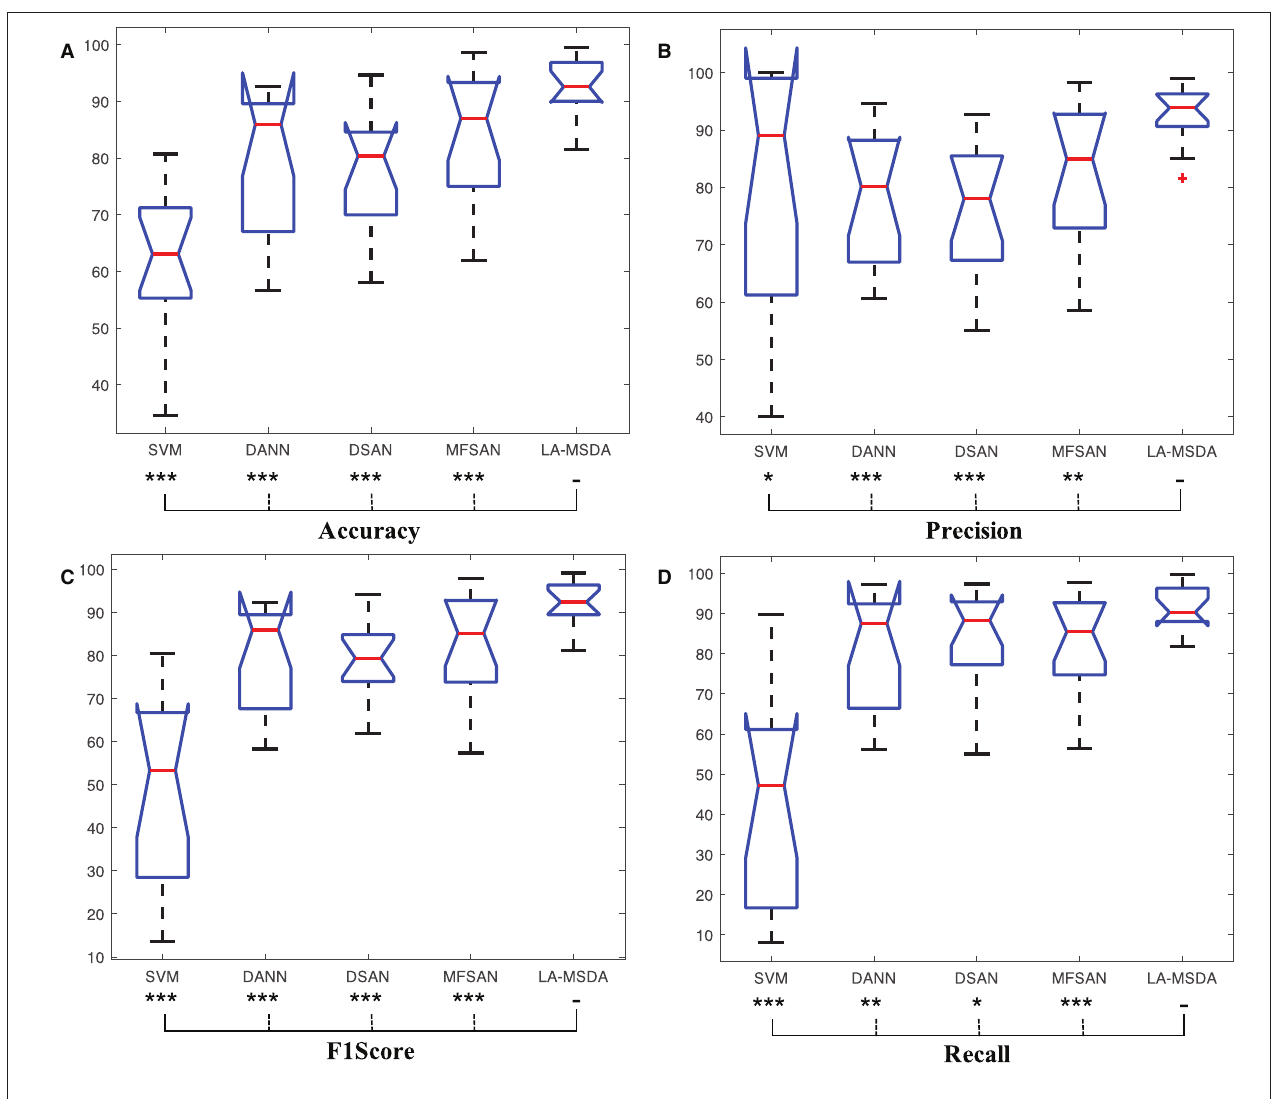
FIGURE 9 | Confidence evaluation. Box plots: four related metrics based on confusion matrix to compare LA-MSDA with Support Vector Machines (SVM), Domain-adversarial Neural Network (DANN), Deep Subdomain Adaptation Network (DSAN), and Multiple Feature Spaces Adaptation Network (MFSAN). (A) Represents the confusion matrix of Accuracy. (B) Represents the confusion matrix of Precision. (C) Represents the confusion matrix of F1Score. (D) Represents the confusion matrix of Recall. * p -value between different models. (* p < 0.05; ** p < 0.01; *** p <